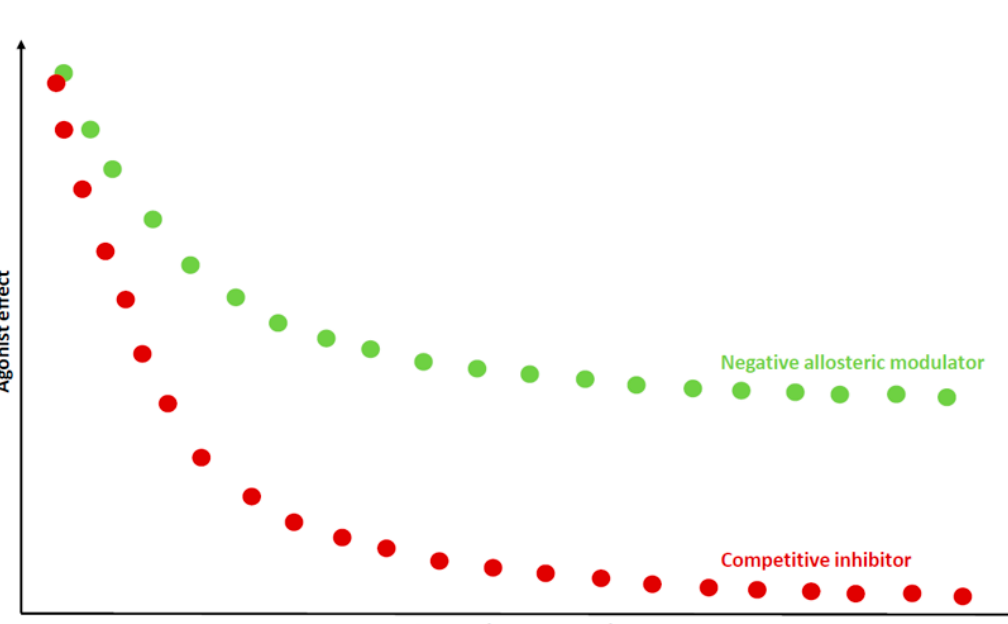
Figure 3. Ceiling effect of negative allosteric modulator. Increasing concentration of the competitive antagonist inhibits the effect of the endogenous agonist until the signaling is quenched (red dots). Increasing concentration of the negative allosteric modulator weakens the signal but does not extinguish it (green dots).